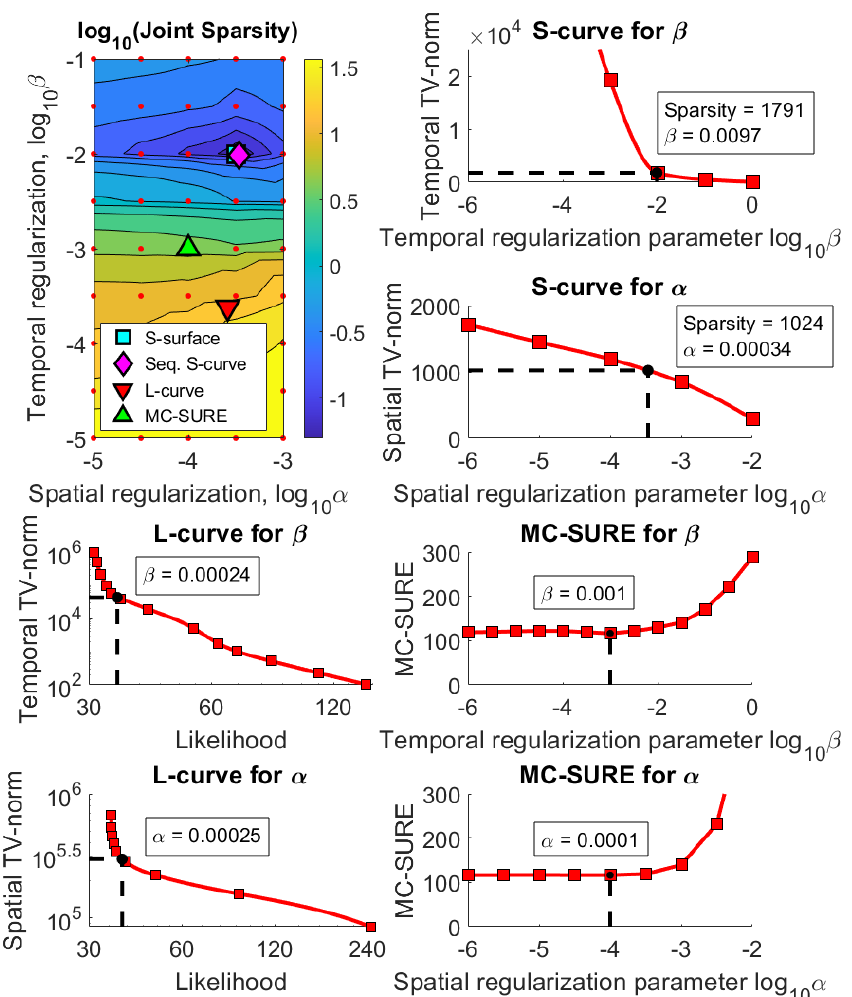
Figure 6. The joint sparsity contour used in the S-surface parameter selection as well as all the param- eter selection curves for the Sequential S-curve, L-curve and MC-SURE methods in the experimental data case. The red dots mark the computational grid of α :s and β :s in the contour, and the red squares mark the 1D grid of regularization parameters in the parameter selection curves. Note that the spatial TV norm for the Sequential S-curve is from a single image frame whereas the spatial TV norm for the L-curve is from the whole image